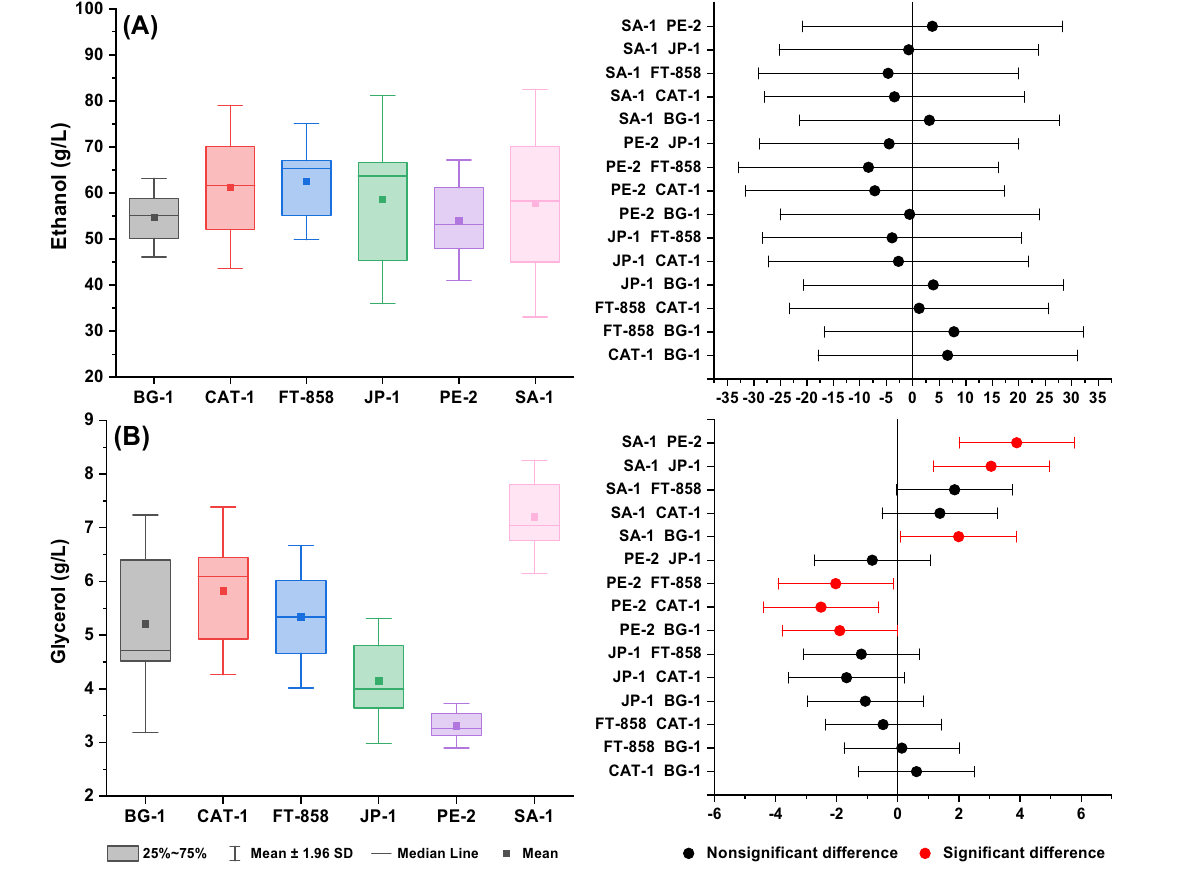
Figure 10. Box charts and means comparison using Tukey mean-difference plot for (A) ethanol production and (B) glycerol production related to BRS AG rice fermentations with S. cerevisiae